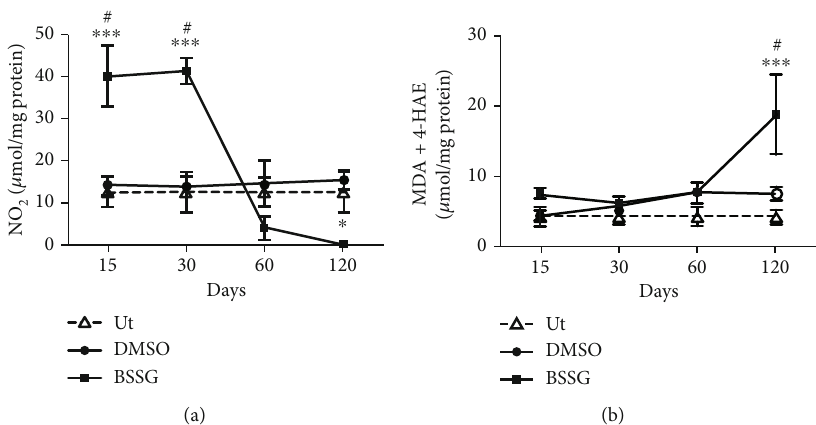
F igure 1: Nitrosative and lipid peroxidation after a BSSG injection in the SNpc. (a) Nitrosative stress was evaluated through the measurement of nitrite levels. (b) Lipid peroxidation was assessed as a proxy for oxidative stress by MDA and 4-HAE determinations. Ut: untreated control rats; Mock: rats injected with vehicle (DMSO); BSSG: rats injected with 6 μ g of BSSG. The values represent the mean ± SD from 4 rats for each time point and each experimental condition. Two-way ANOVA and Bonferroni post hoc tests were applied. ( ∗∗∗ ) indicates a P < 0 : 001 for statistical di ff erence between the BSSG group compared with the Ut group or (#) for the respective mock